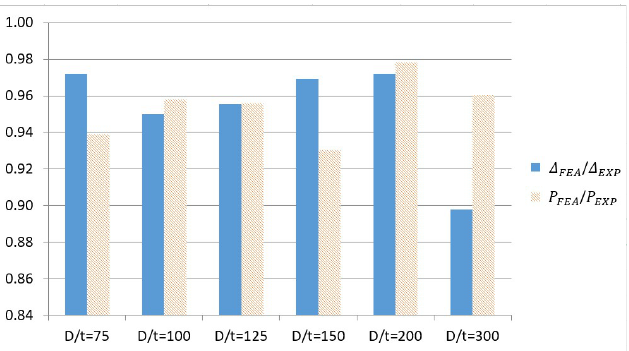
Figure 8. Comparison between the results of FEA by authors and experimental tests by Lanhui Guo et al. for deflection and load capacity is for specimens with 𝐷 𝑡 ⁄ ranging from 75 to 300.